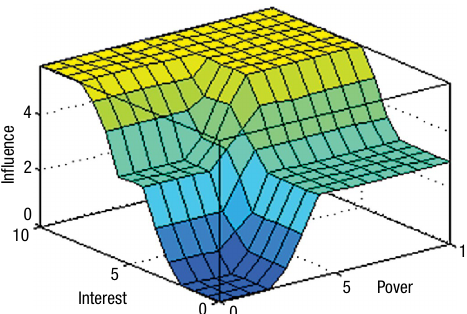
Fig. 4. Plot of the influence dependence on interest and power when other factors are fixed: benevolence = neutral and reliability = 4.5 (partially neutral , partially low